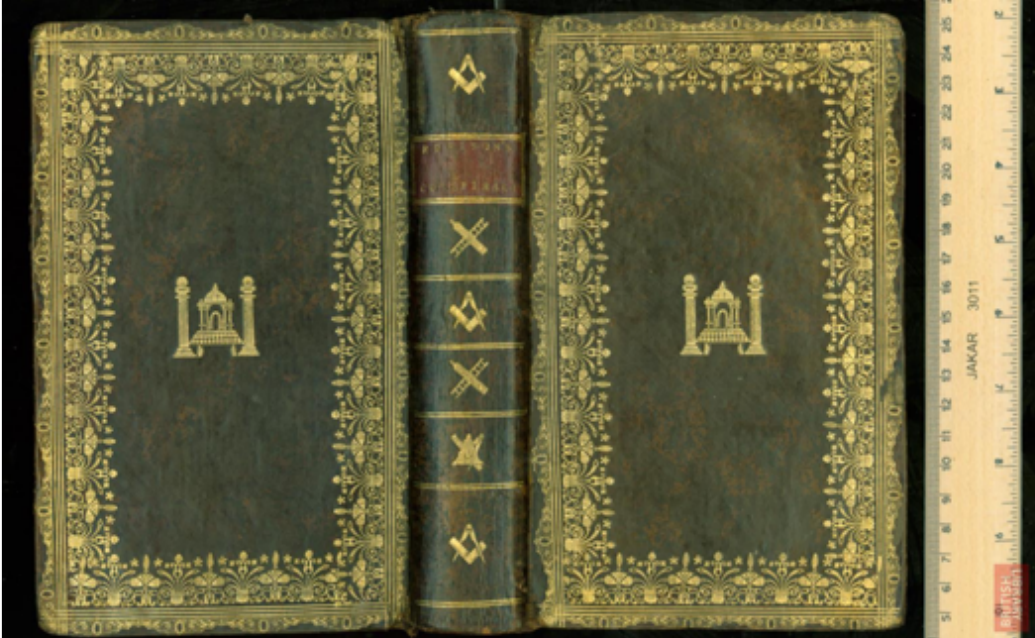
Fig. 44a. John Robinson, Proofs of a conspiracy against all the religions and governments of the world (Dublin, 1798). BL, C.190.e.12.